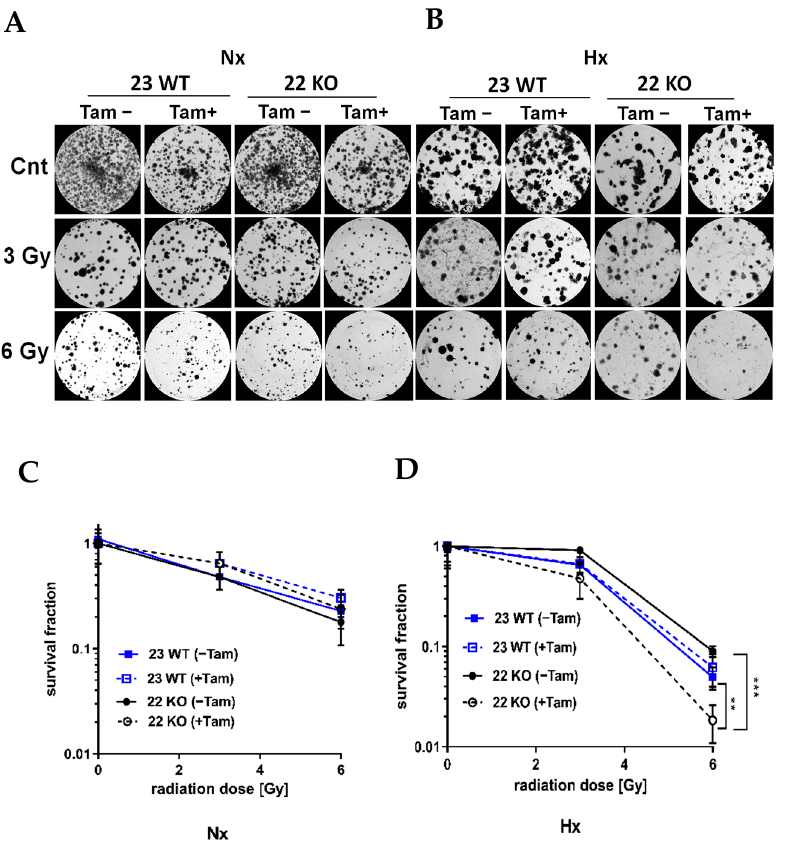
Figure 7. Survival of mHDC in response to irradiation with up to 6 Gy in normoxia (NX) or hypoxia (HX) as determined by colony formation assay (CFA). Hypoxic cells were cultured at 1% O 2 in rat collagen coated 6-well dishes. After IR, the cells designated HX were placed in hypoxia for 10 days.